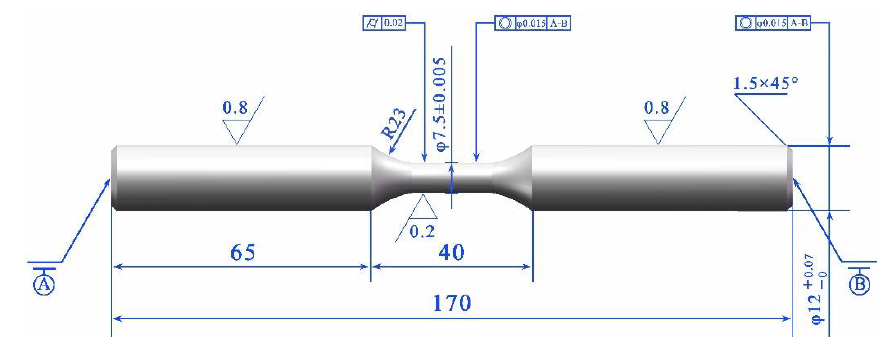
Figure 3. Size of the rotating bending fatigue samples (dimensions in